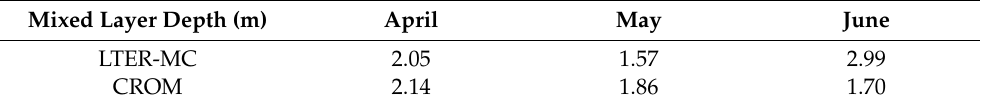
Table 11. MLD observed and simulated by CROM. Mixed Layer Depth